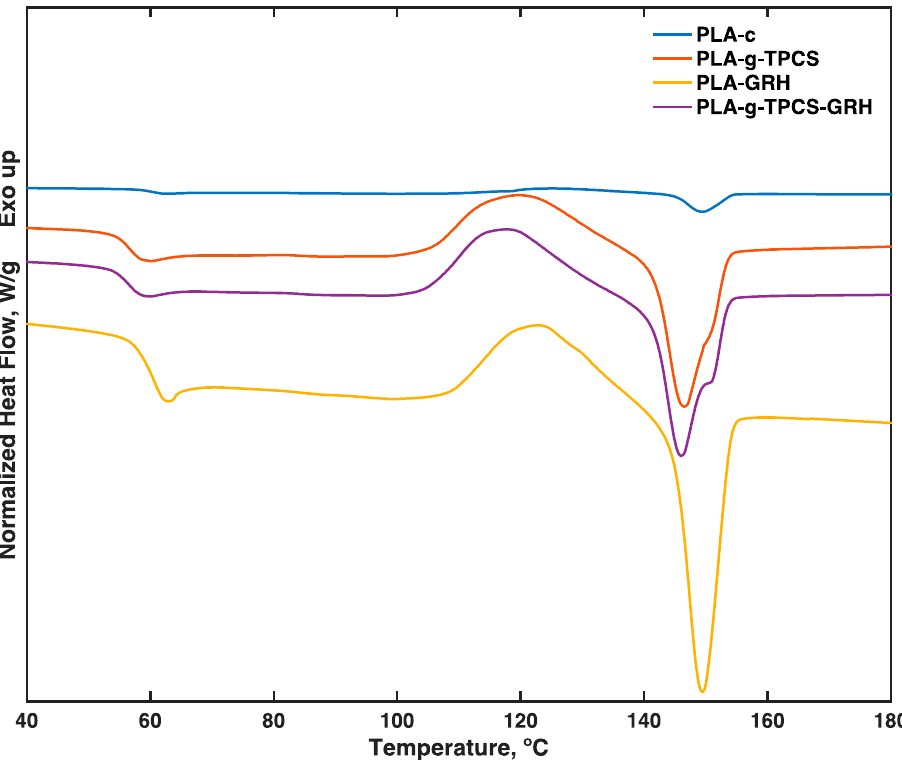
Figure 5. DSC thermograms of the second heating cycle of the tested films; samples were produced by twin-screw extrusion followed by cast-film extrusion.